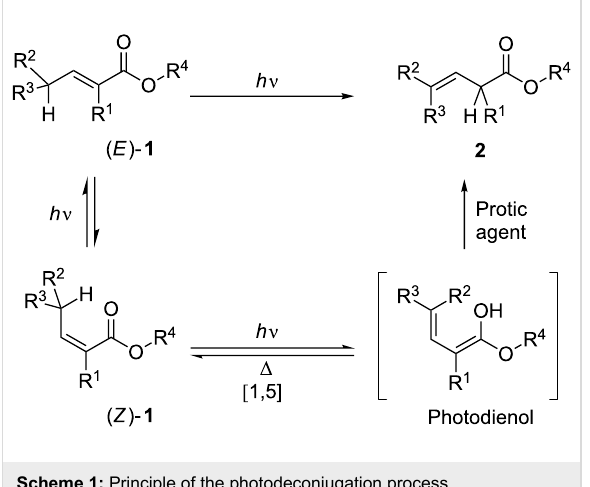
Scheme 1: Principle of the photodeconjugation process.